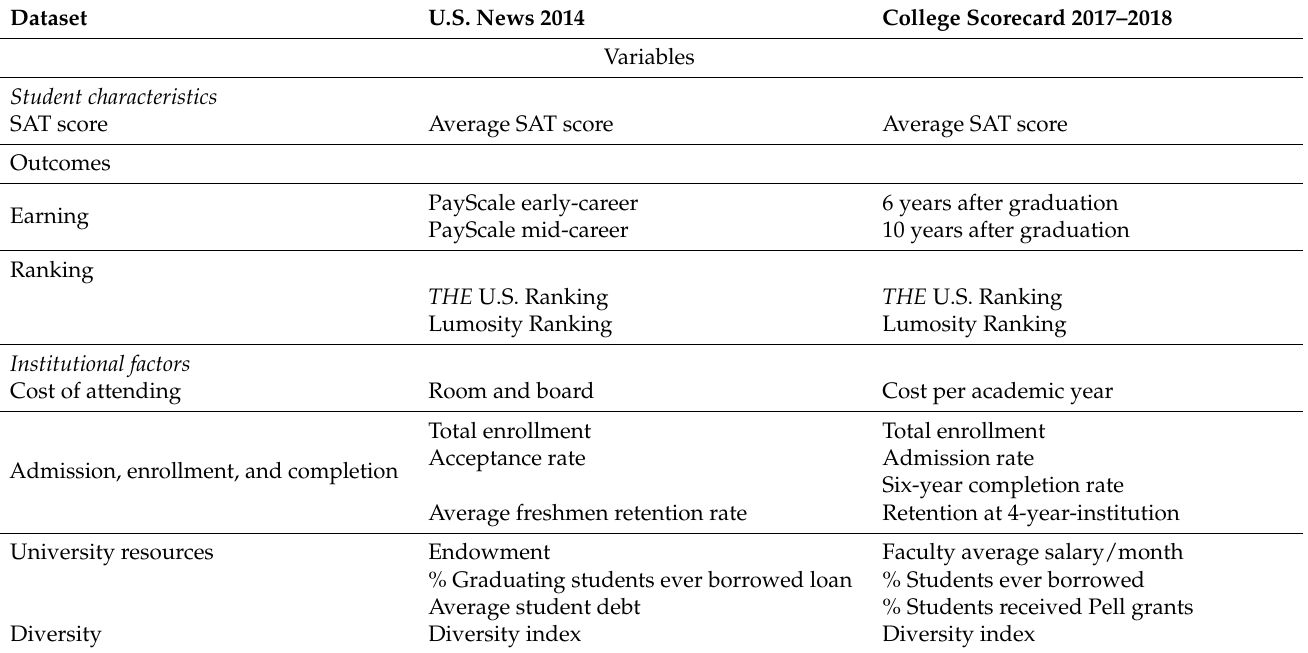
Table 1. Variable selection and